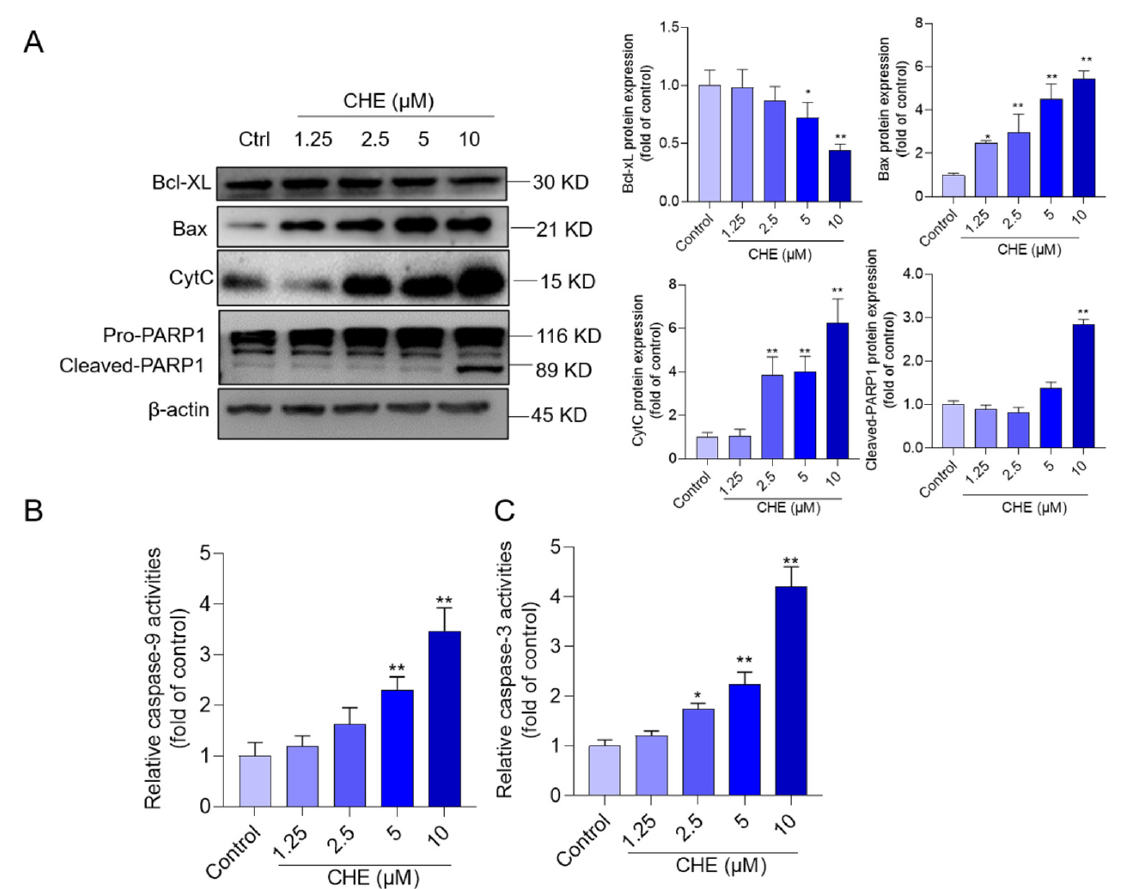
Figure 5. CHE treatment activates the mitochondrial apoptotic pathway in HepG2 cells. ( A ) cells were treated with various doses of CHE, i.e., 1.25, 25.5, 5, and 10 µ M, respectively. After 24 h, the expressions of Bcl-XL, Bax, CytC, and PRRP1 proteins were examined using the Western blotting method. ( B , C ) the levels of caspase-9 (B) and caspase-3 (C) activities. Data are shown as mean ± SD ( n = 3 independent experiments). * p < 0.05 or ** p < 0.01, compared to those in the vehicle group.